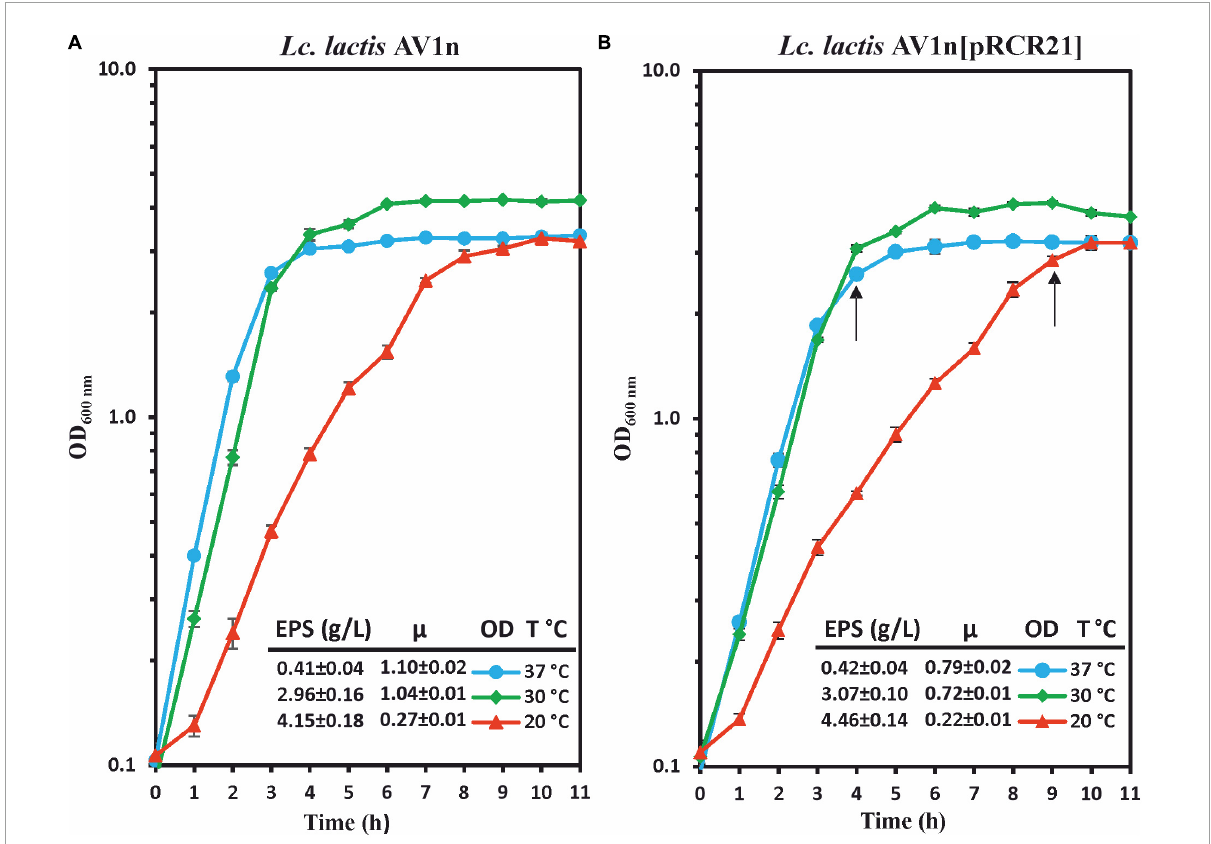
FIGURE1 Analysis of growth and dextran production by Lc. lactis AV1n (A) and Lc. lactis AV1n[pRCR21] (B) . Bacteria were grown in MRSS at 20 ◦ C, 30 ◦ C, and 37 ◦ C. Levels of dextran produced by the LAB at OD 600 nm = 1.0 are also depicted. The mean values and the standard deviation of three independent experiments are depicted. Arrows indicated the time at which samples for the proteomic analysis were